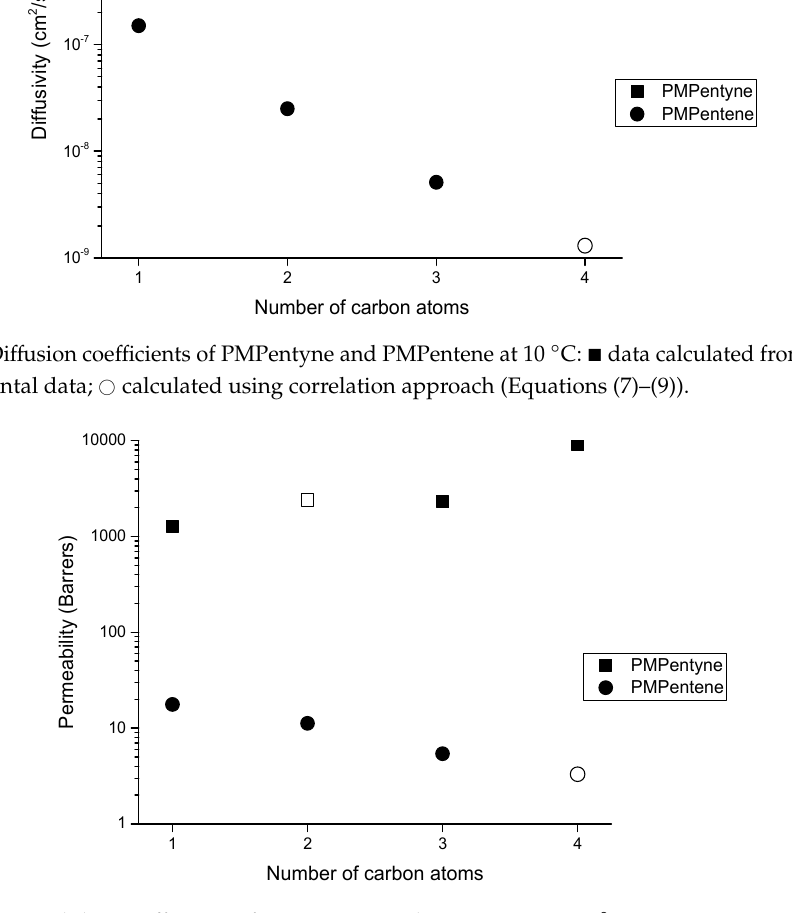
Figure 7. Diffusion coefficients of PMPentyne and PMPentene at 25 °C: data calculated from D = P / S , experimental data; calculated using correlation approach (Equations (7)–(9)).